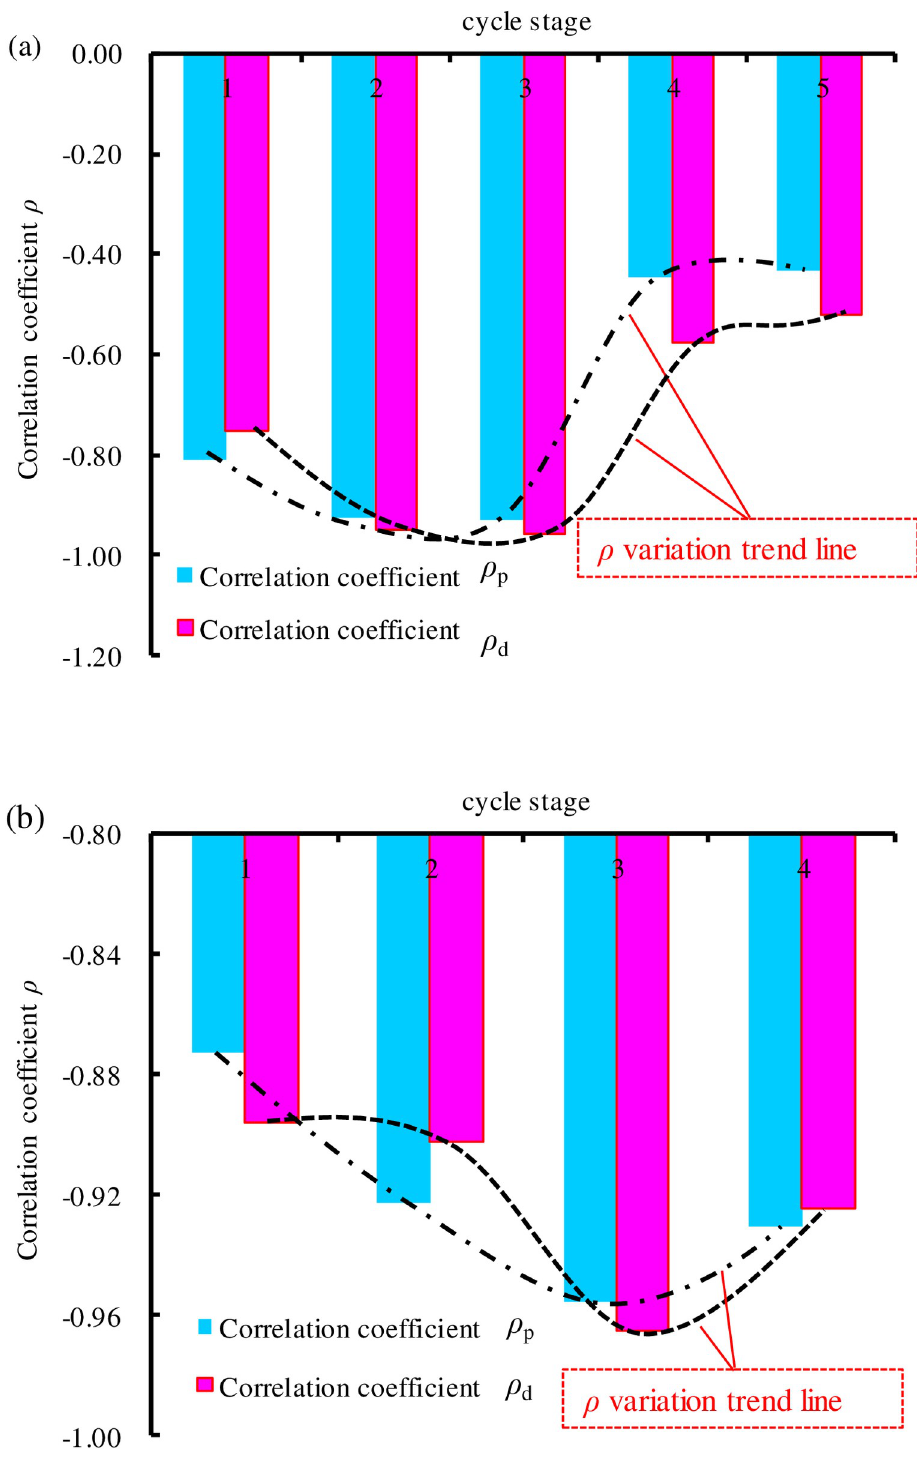
Fig 13. Correlation coefficient curve: (a) SS-1; (b) SS-2.